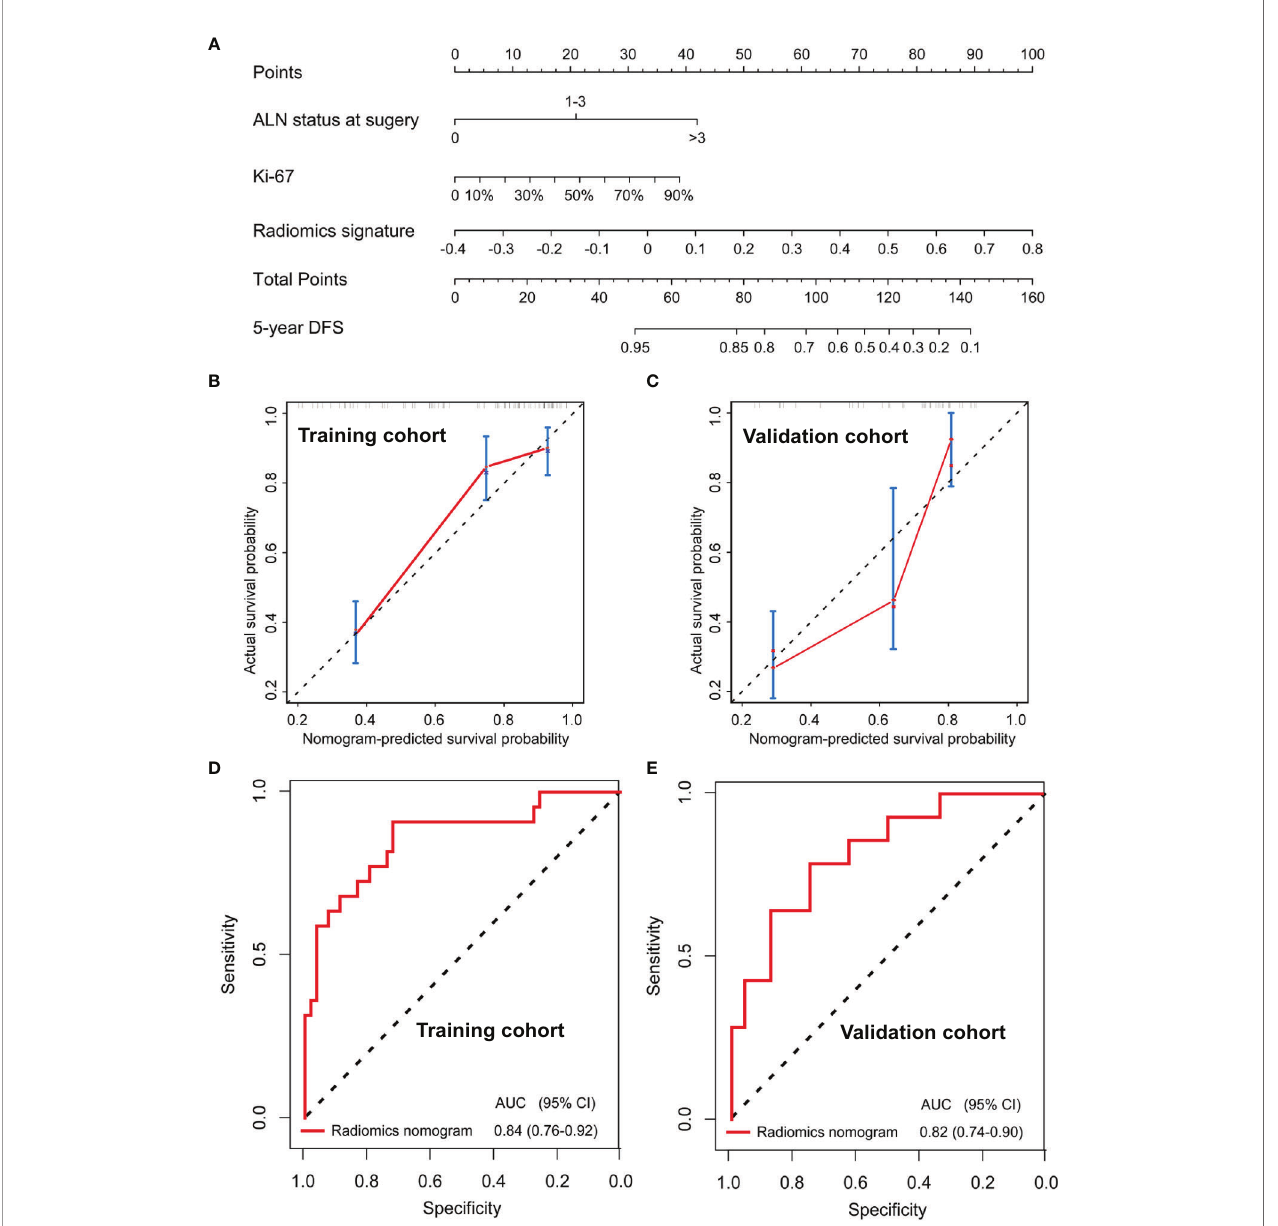
FIGURE 4 | Nomogram for the prediction of disease-free survival (DFS) in breast cancer patients who had residual tumors after neoadjuvant chemotherapy (A) . Calibration curves of the nomograms developed in the training (B) and validation (C) cohorts. The ROC curves of the radiomics nomogram in the training (AUC, 0.84) and validation (AUC, 0.82) cohorts (D, E)